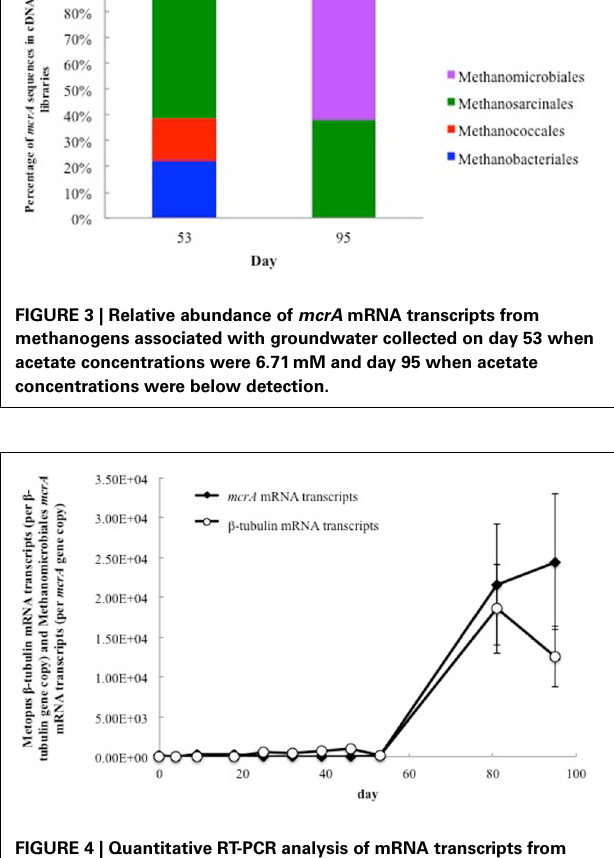
FIGURE 4 | Quantitative RT-PCR analysis of mRNA transcripts from Methanomicrobiales mcrA and Metopus ß-tubulin genes in groundwater collected from well CD-01 over the course of the field experiment. The number of mRNA transcripts per µ g total RNA were normalized against the number of gene copies per µ g total